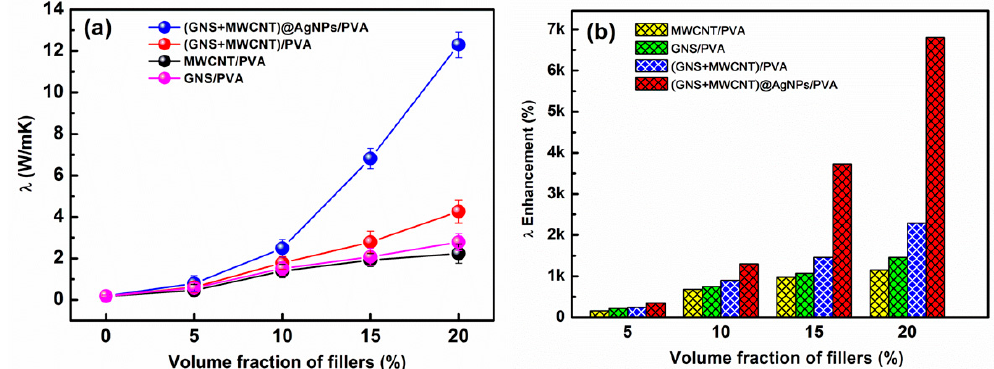
Figure 4. Thermal conductivity λ ( a ) and thermal conductivity enhancement ( b ) of GNS/PVA, MWCNT/PVA, (GNS-MWCNT)/PVA, and (GNS-MWCNT)@AgNPs/PVA nanocomposite films with different volume fractions of fillers.